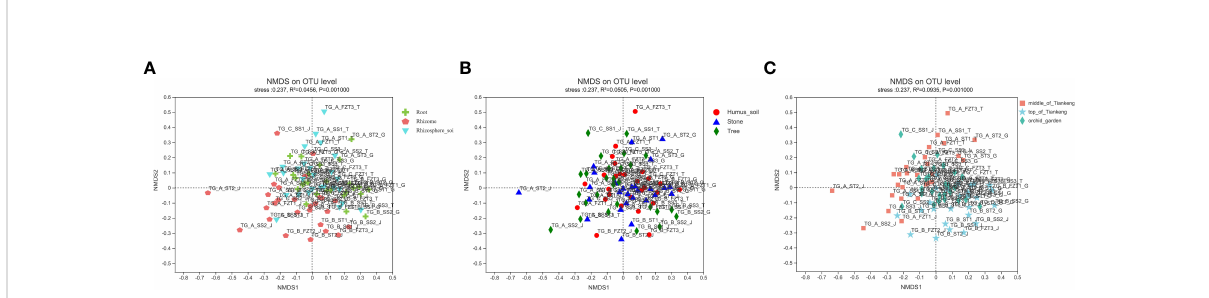
FIGURE 6 NMDS analysis. Points of different colors or shapes represent samples of different groups. The closer the two sample points are, the more similar the species composition is. (A) : root, rhizome and rhizosphere soil groups; (B) : different habitat groups; (C) : different altitude groups.